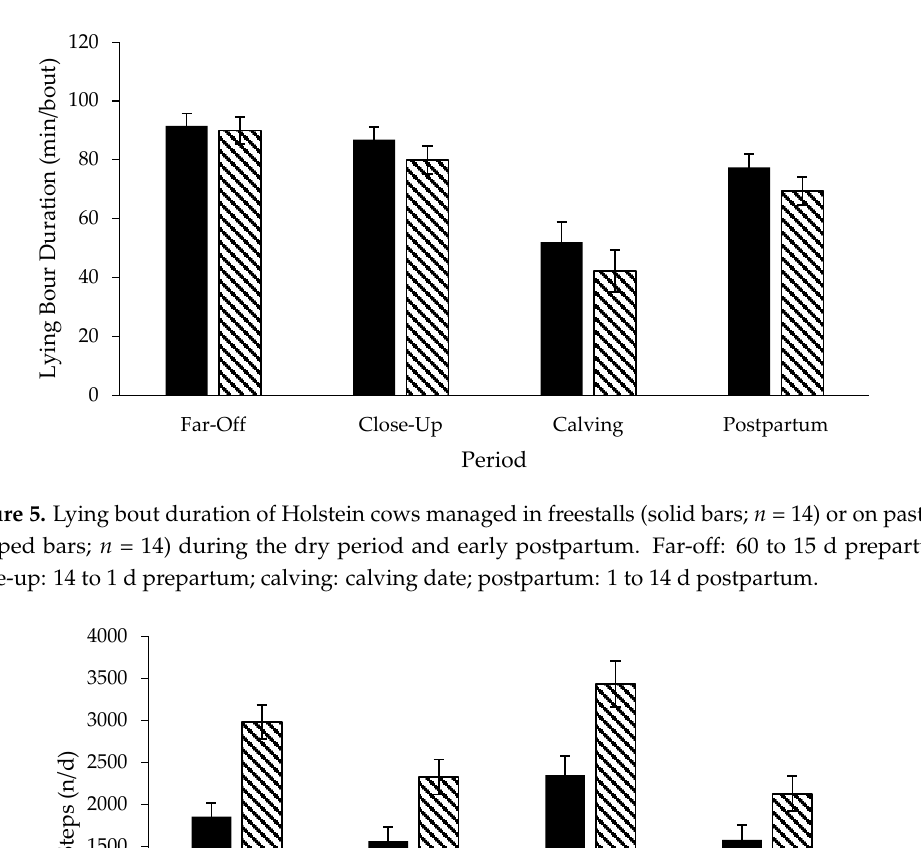
differences between and within treatments ( p < 0.05).